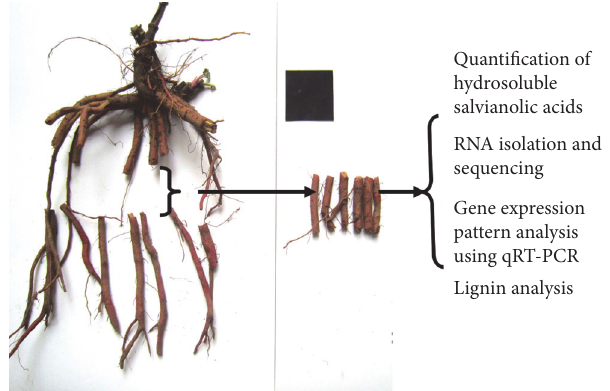
Figure 1: The root segments of S. miltiorrhiza for further